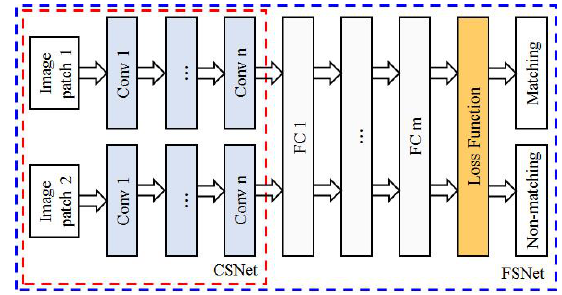
Figure 2. Architecture of the networks used in this paper.